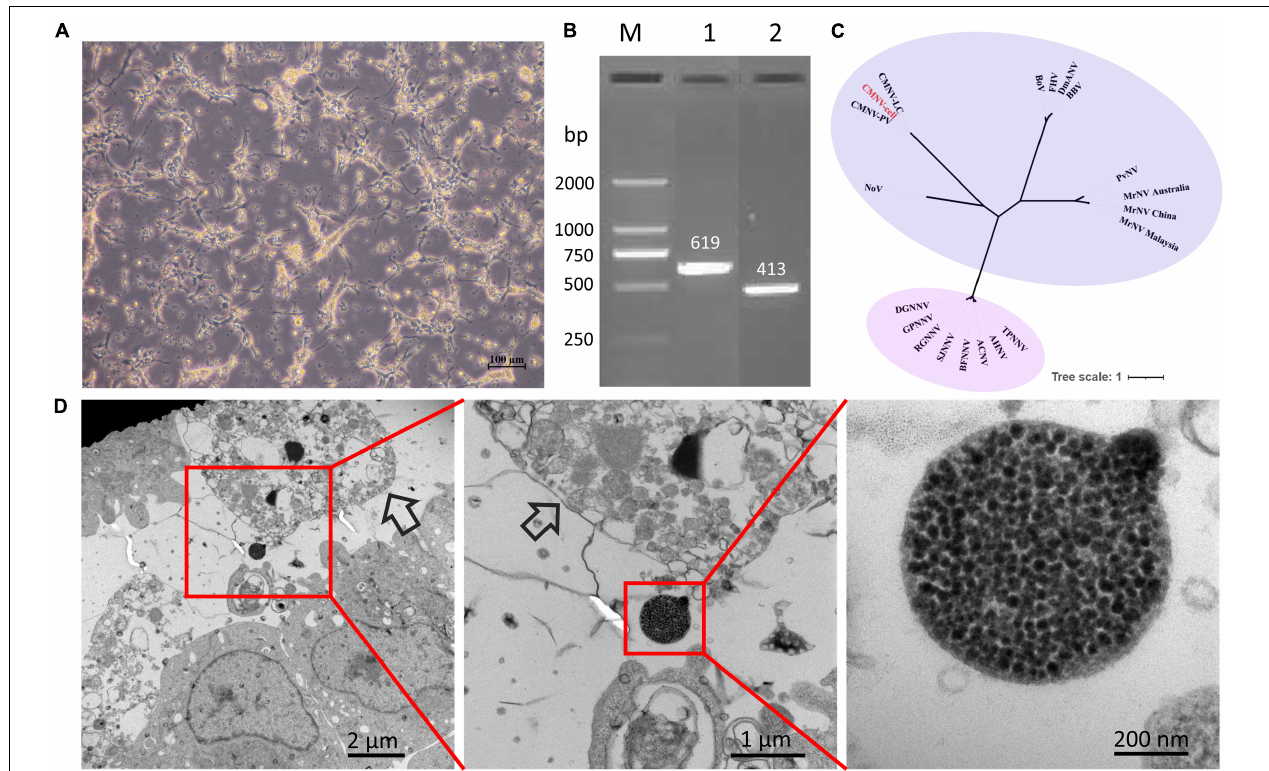
FIGURE 5 | The analysis results of CMNV infection in the EPC cells. (A) Cytopathic effect in EPC cells infected with CMNV; (B) Analysis of agarose gel electrophoresis of CMNV RT-nPCR amplicons; (C) phylogenetic tree analysis of the partial sequences of RNA-dependent RNA polymerase (RdRp) gene from different CMNV isolates and other nodaviruses (for virus abbreviations see Supplementary Table 1 ). The phylogenetic tree based on the partial sequences of RdRp gene was generated by the neighbor-joining method using the MEGA 7.0 program, and the scale bar was 1. (D) Transmission electron microscopic micrographs of ultrathin sections of EPC cells infected with CMNV. Scale bars, 2 µ m, 1 µ m, and 200